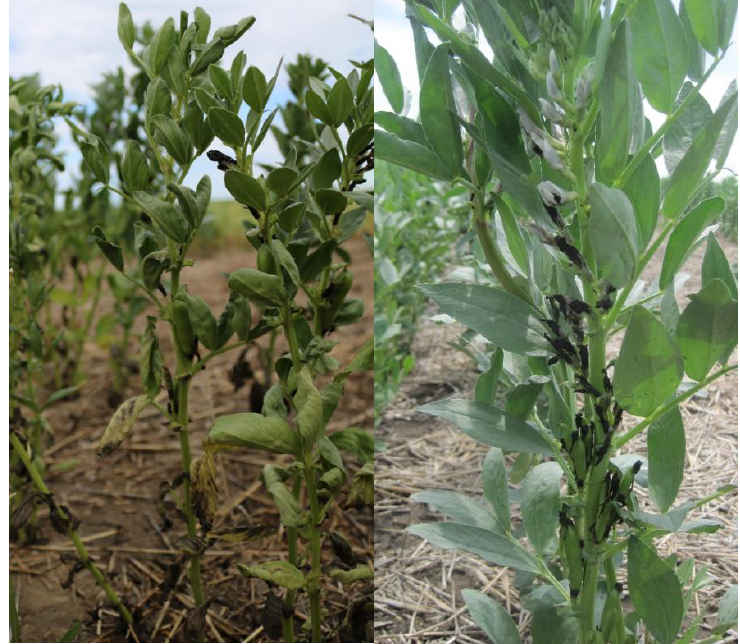
Figure 1. Faba bean plants (FB 9-4) under water-deficit conditions ( left ) and irrigated conditions ( right ) in Limerick and Outlook, Saskatchewan (Canada), respectively.